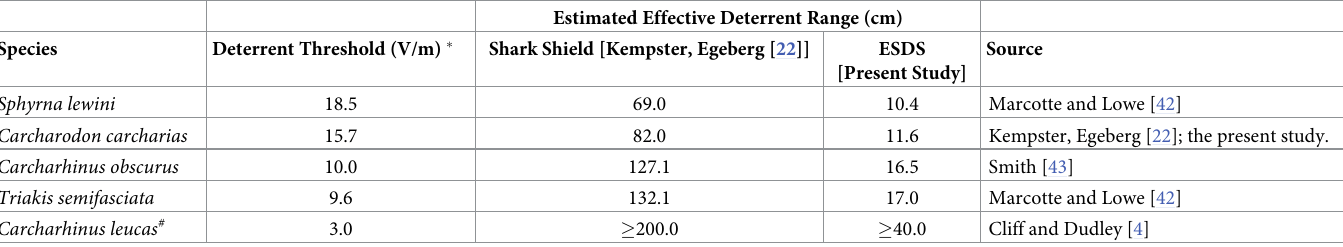
Table 4. Estimated effective deterrent range of the Shark Shield and ESDS for five shark species, based on their highest reported deterrent threshold (V/m). Estimated Effective Deterrent Range